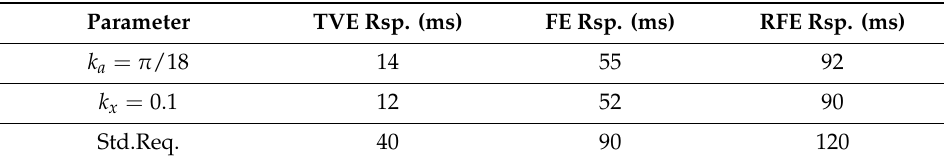
Table 2. Response time under step change